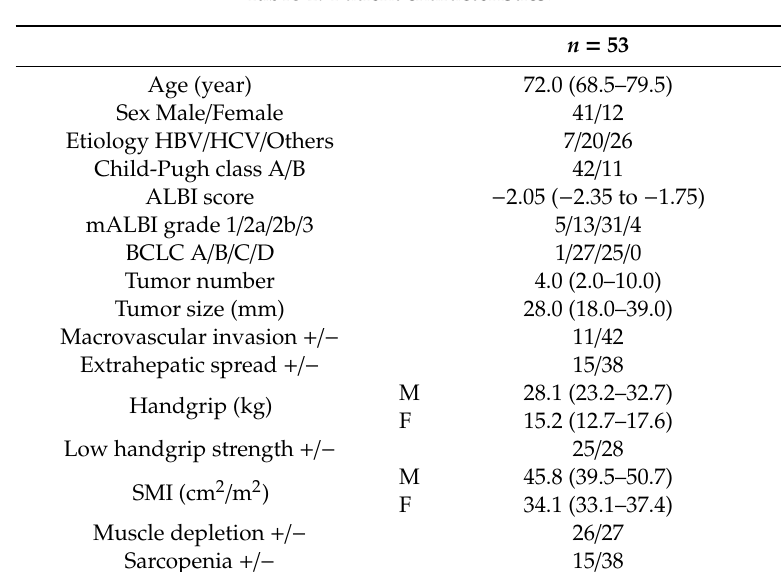
Table 1. Patient